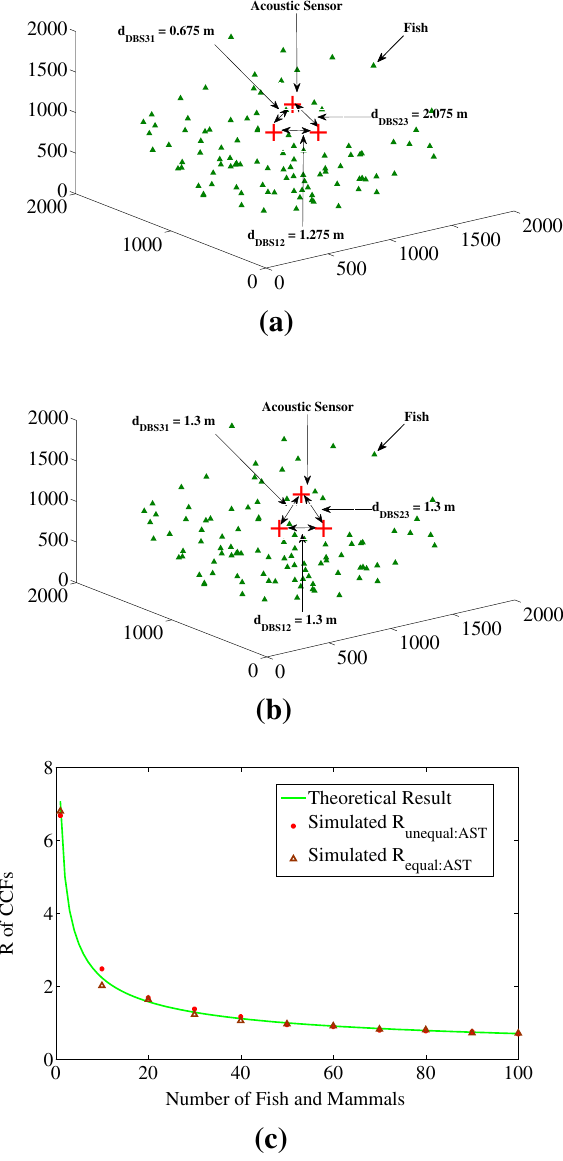
Figure 7. Scenario of unequal sensor separation and its corresponding results from simulations for three acoustic sensors AST scheme ( a ) unequal sensors separation where d DBS12 = 1.275 m, d DBS23 = 2.075 m and d DBS31 = 0.675 m ( b ) corresponding equal distance among acoustic sensors, i.e., d DBS = 1.3 m, derived from condition at Eq. (22) and ( c ) Number of fish and mammals vs. R of CCFs for theoretical, and simulated with unequally and corresponding equally spaced acoustic sensors where the sensor distances are similar as in ( a ) and ( b ). Here, the axes units are in meter for ( a ) and ( b ). We used MATLAB R2010a to achieve these